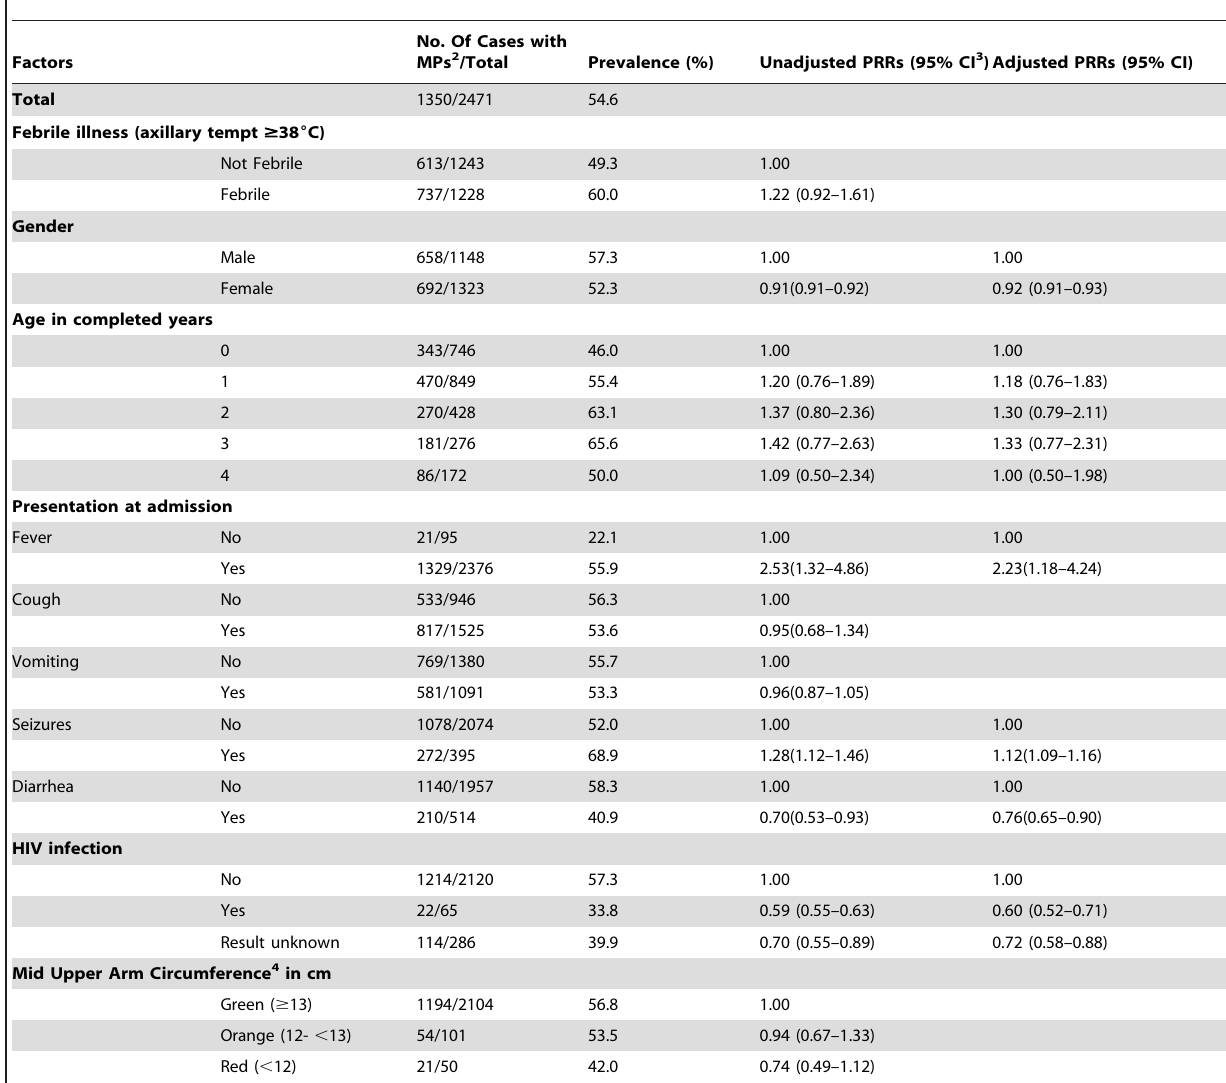
Table 2. Prevalence and PRRs 1 of confirmed malaria among hospitalized children at Bikira and Kalisizo health centers (May/2011–